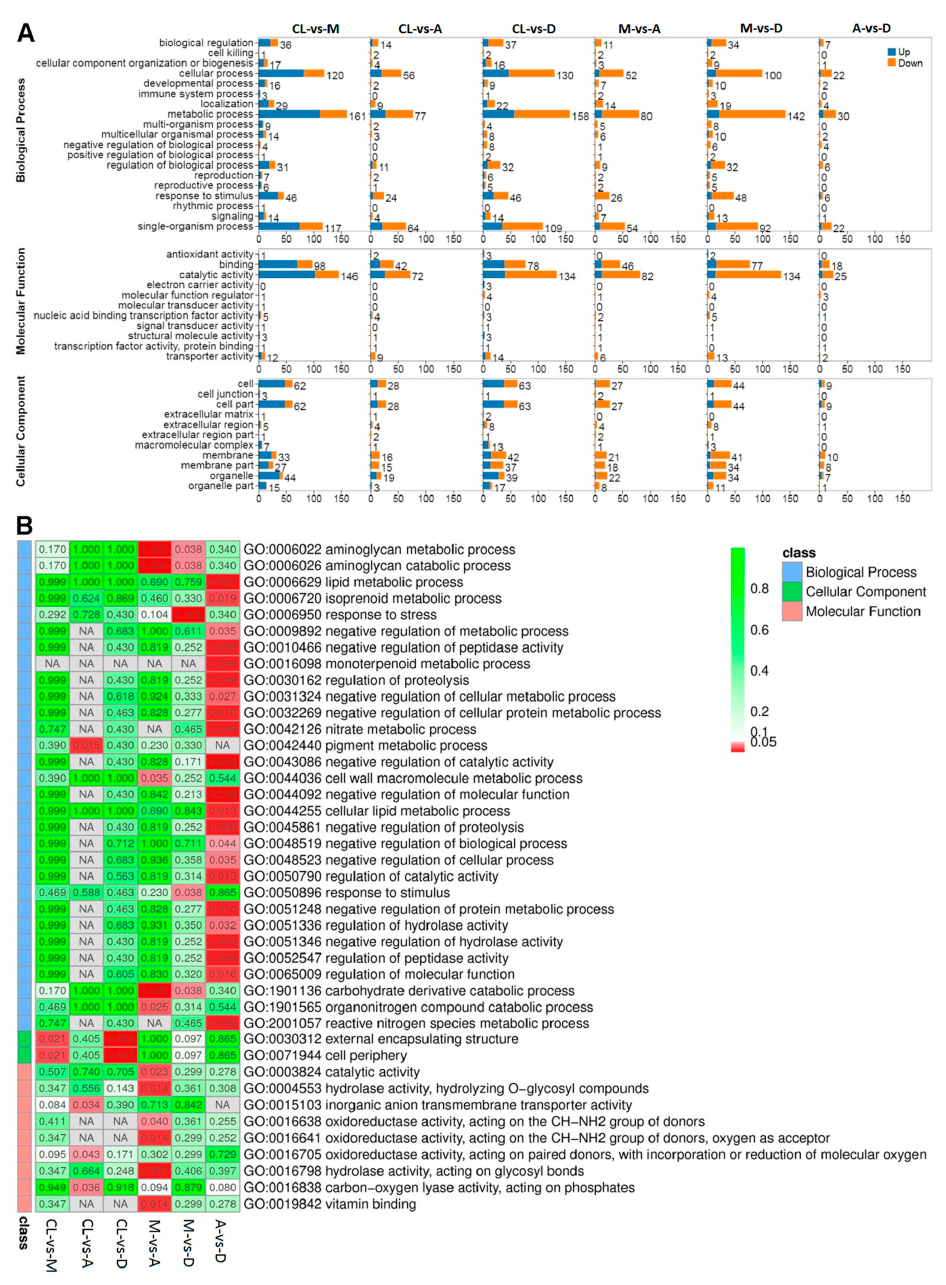
Figure 4. DEGs GO / Pathway enrichment analyses between different light regimes. ( A ) Summary of the distribution and number of DEGs in three ontology classes, including molecular function, cellular component, and biological process. ( B ) Q-value heatmap of the GO pathway enrichment of the three main ontology classes. The color scale indicates the Q-value. Darker coloration indicates more significant enrichment.